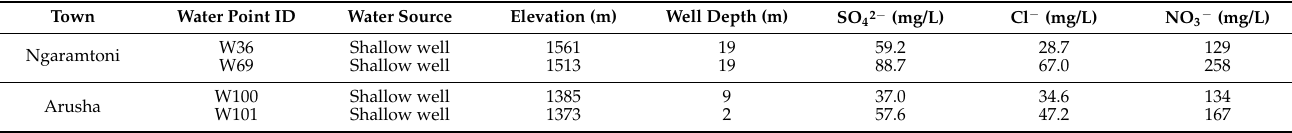
Table 8. Water samples containing an unusually high concentration of NO 3 − on the southwestern